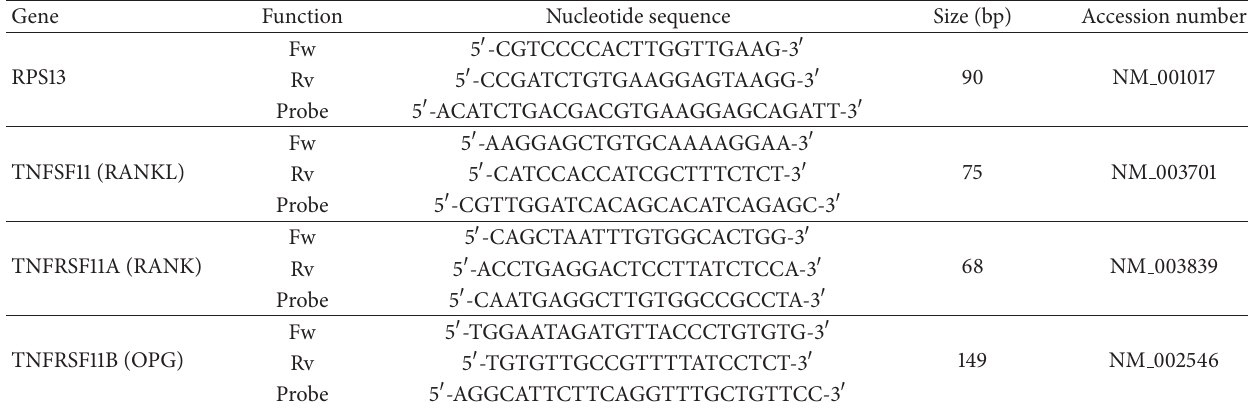
Table 3: Human primers used for real-time PCR.